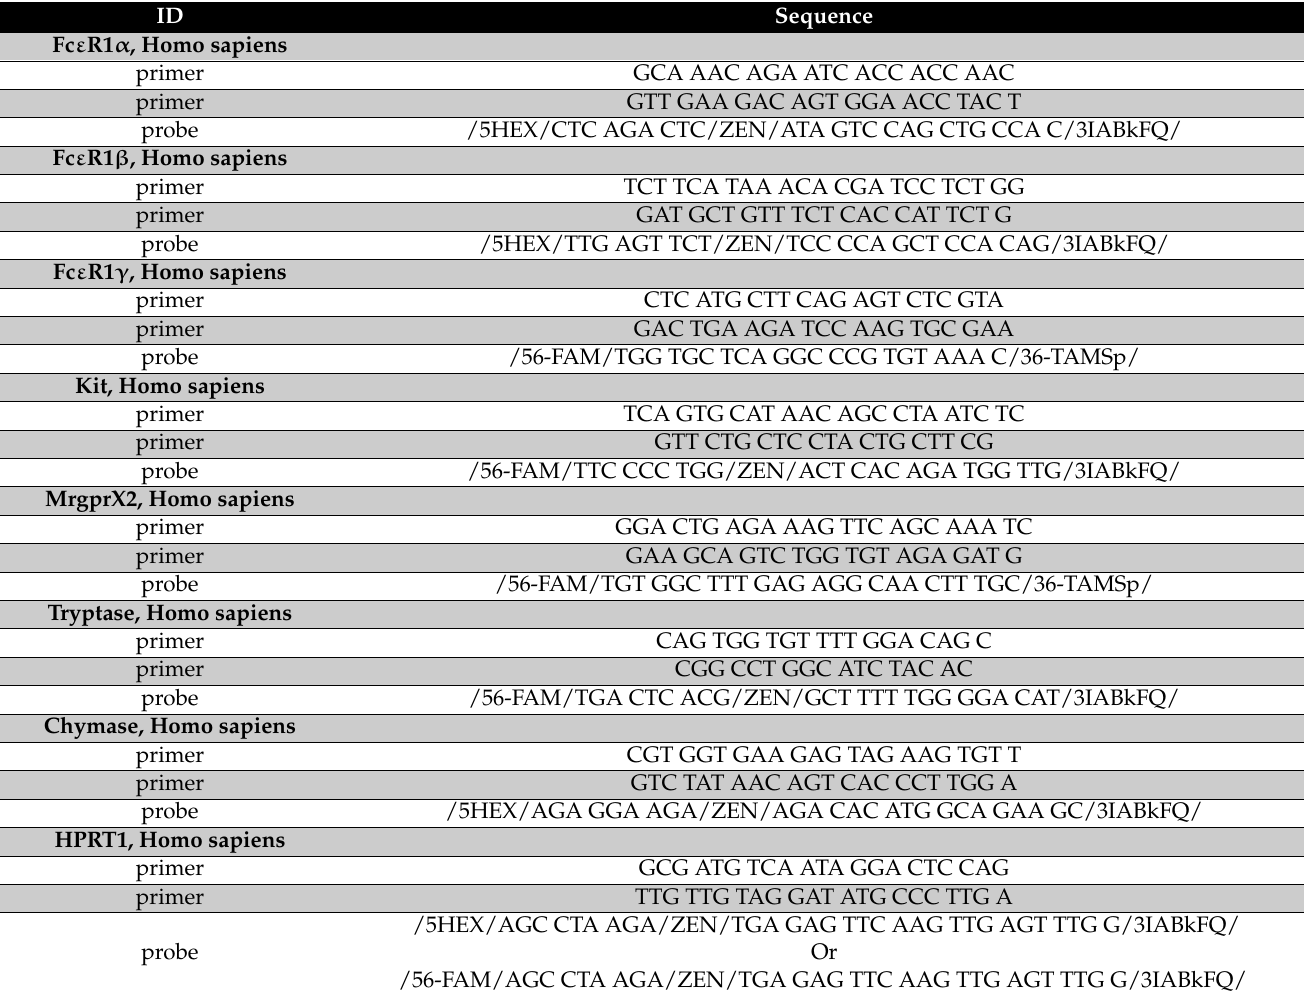
Table 2. Primer and probe sequences used for real-time PCR